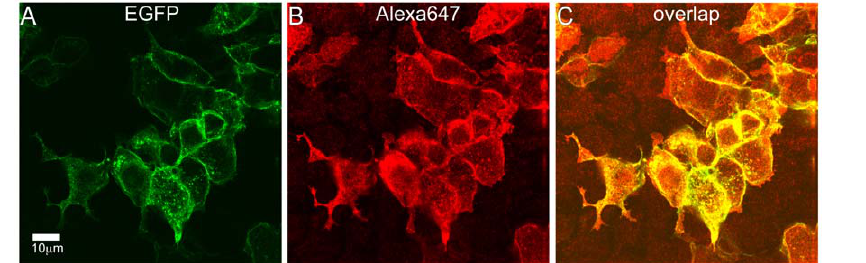
Figure 10. Dual-color CLSM images of HEK293 cells transiently expressing NBCe1-A-EGFP immunostained with Alexa Fluor 647 conjugated antibody. Post fixation, cells were immunolabeled with the primary anti-wt-NBCe1-A antibody and the secondary Alexa Fluor 647 conjugated antibody. Panel A shows the fluorescence image taken in channel 0 (green), Panel B shows the image recorded in channel 1 (red), and Panel C is the overlap of the two. The image contrast was enhanced for better visualization of non-specific binding of the secondary Alexa Fluor 647 conjugated antibody to HEK293 cells. The pixel size is 0.0921 m m.